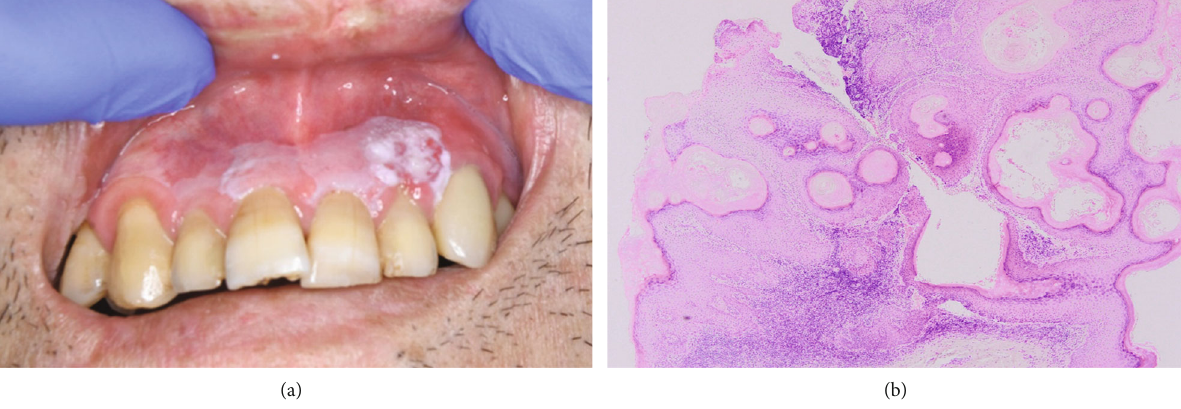
Figure 3: Clinical photographs (April 2021). (a) Compared to the April 2019 photograph, white lesions in the maxillary anterior gingiva have clearly developed and plaque formation is observed. (b) Surgical specimen shows severe dysplasia (hematoxylin-eosin stain, original magni fi cation ×